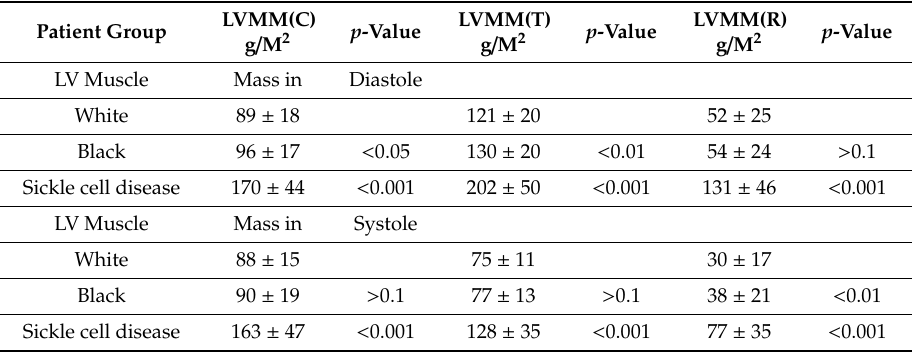
Table 2. Left Ventricular Muscle Mass by Echocardiography.